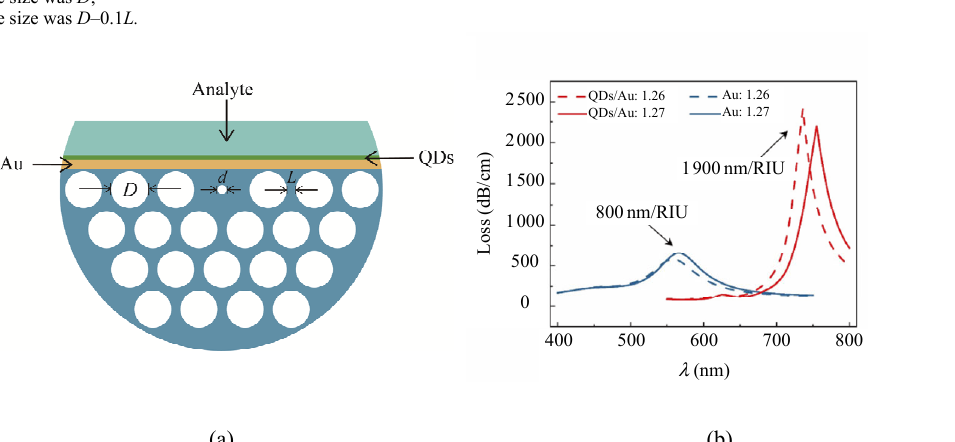
Fig. 7 Simulation results for D-shaped PCF: (a) schematic illustration of the PCF RI sensor coated with the Au and QDs films on the polished surface of D-shaped fiber: D =1.6 μ m, d =0.4 μ m, and L =0.4 μ m; (b) loss spectra for QDs/Au and Au sensors when n a was set to be 1.26 and